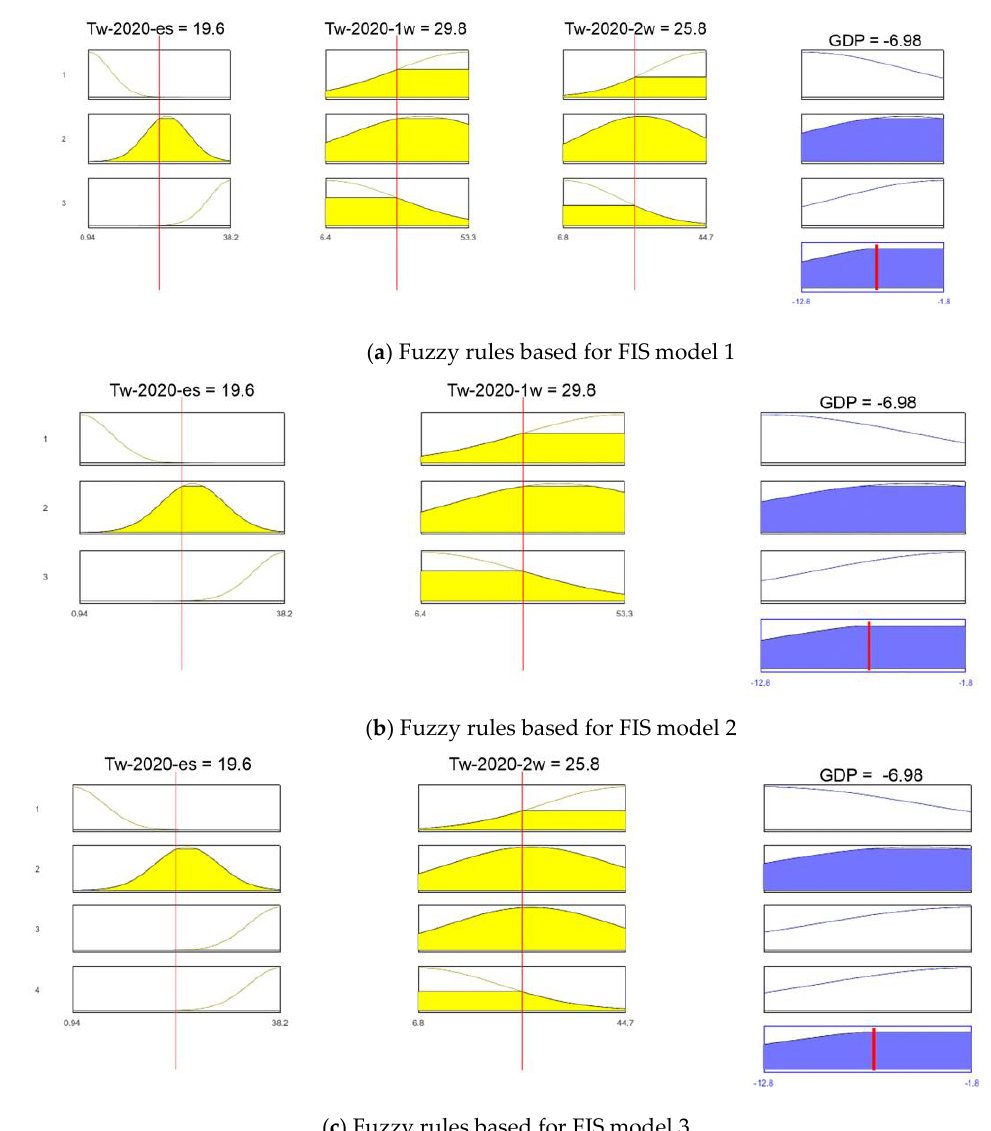
Figure 8. The fuzzy rules based for the FIS models 1, 2, and 3.